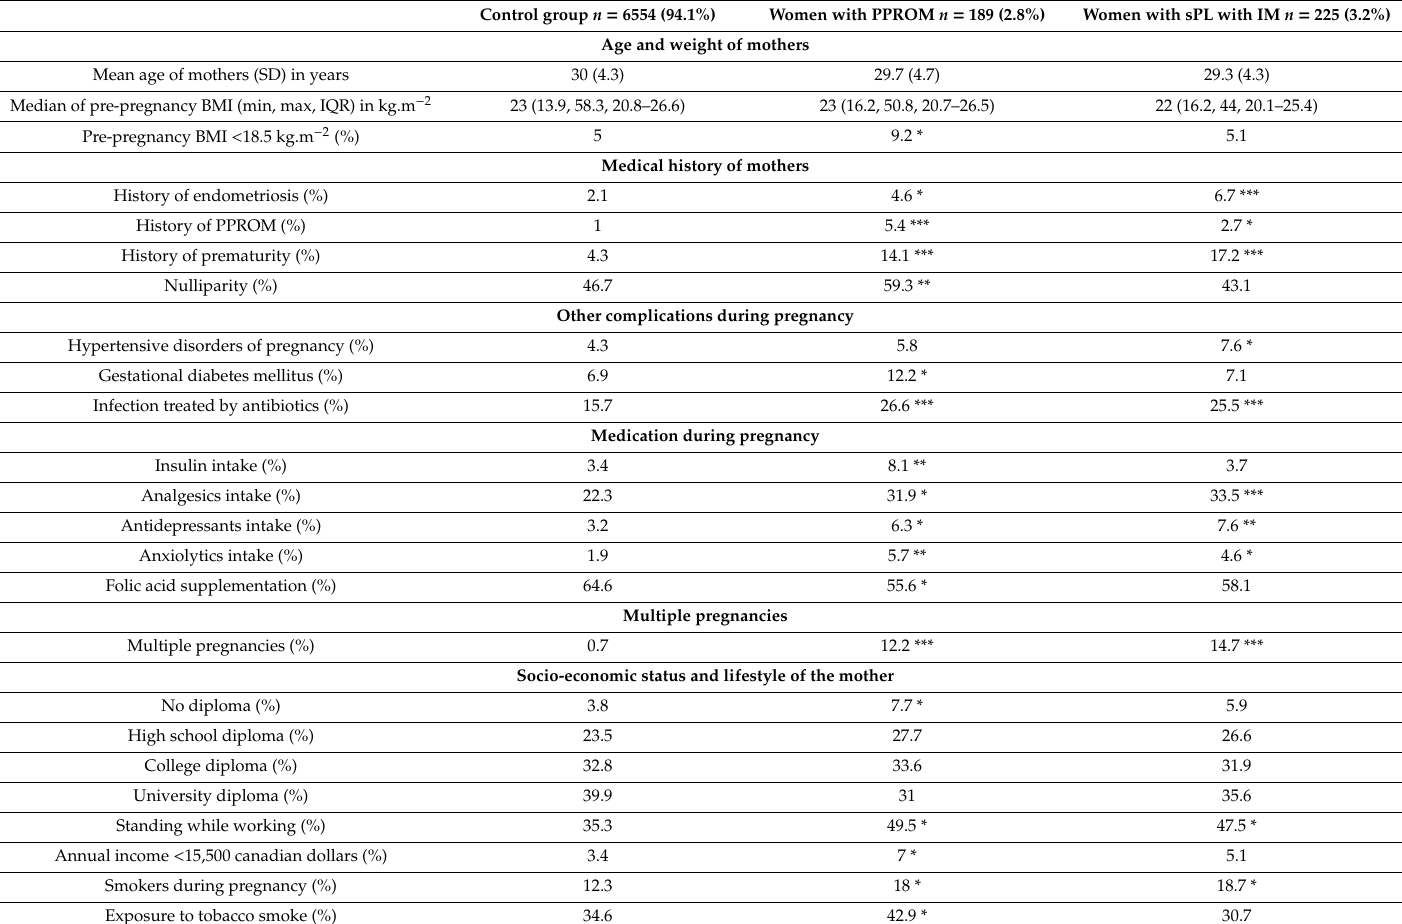
Table 1. Risk factors of preterm premature rupture of